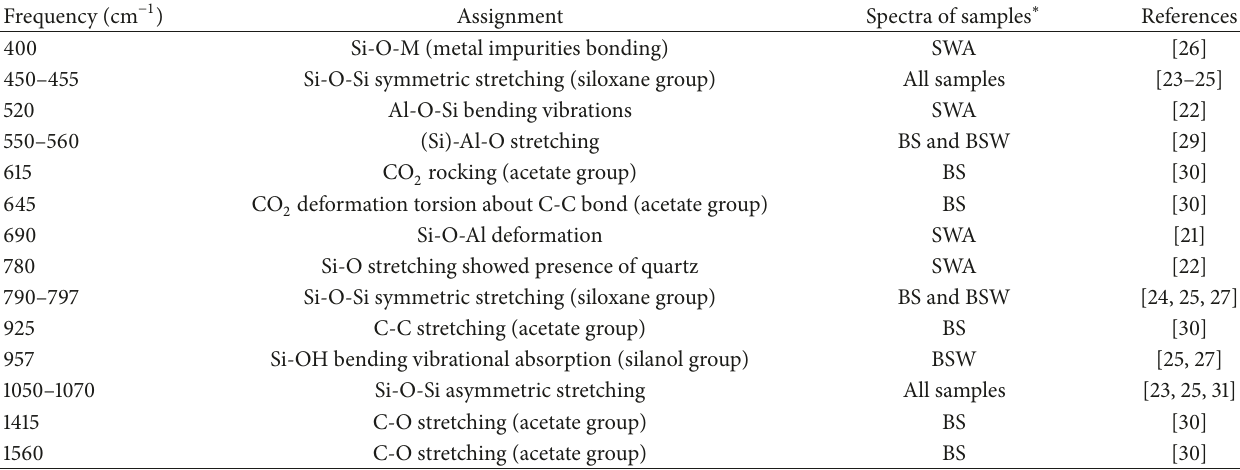
Table 4: Assignments of the IR vibrations of studied samples.